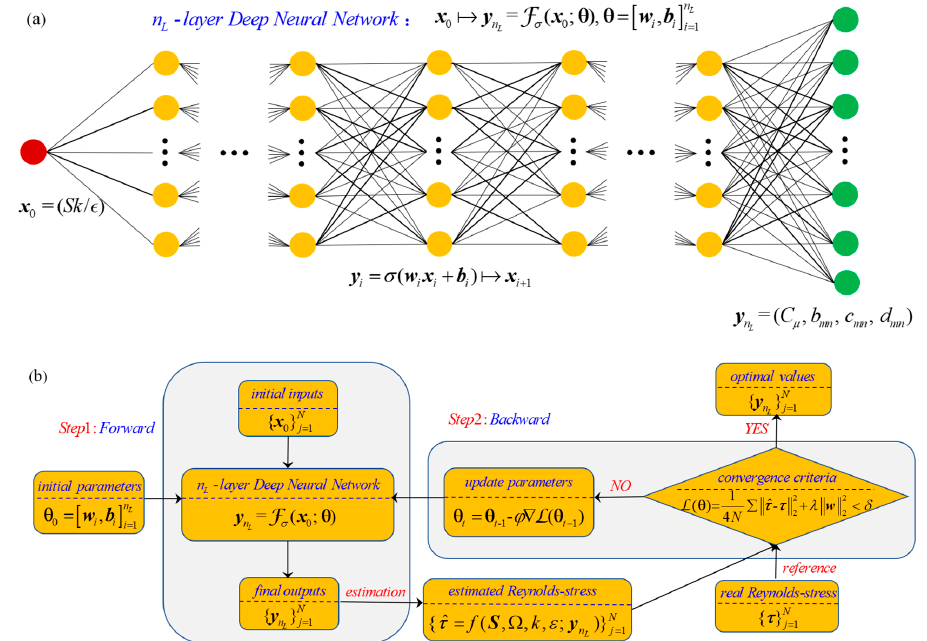
Figure 2. A schematic of the designed data-driven model to determine the closure coefficients: ( a ) the deep neural network (DNN) architecture to map the initial inputs to the finial outputs, and ( b ) the optimization procedure to train this DNN-based data-driven model in ( a ).